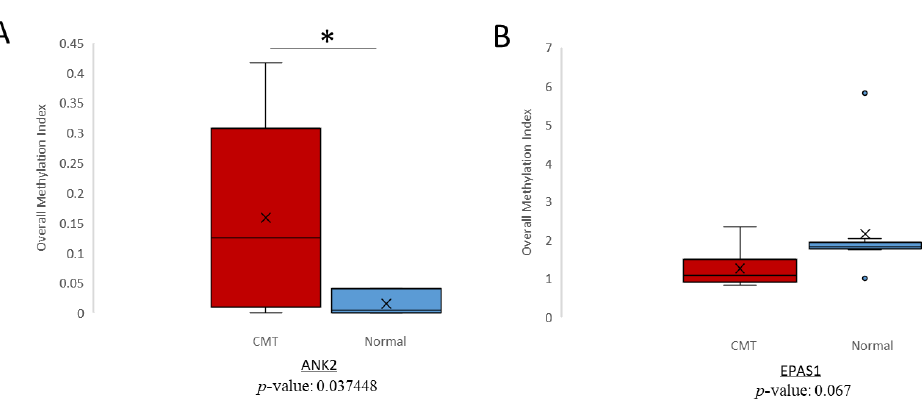
Figure 4. Canine Mammary Tumor (CMT) hypermethylation analysis in cfDNA. Overall methylation index for ( A ) ANK2 and ( B ) EPAS1 in CMT (red) and normal (blue) cfDNA. * = p -value < 0.05.